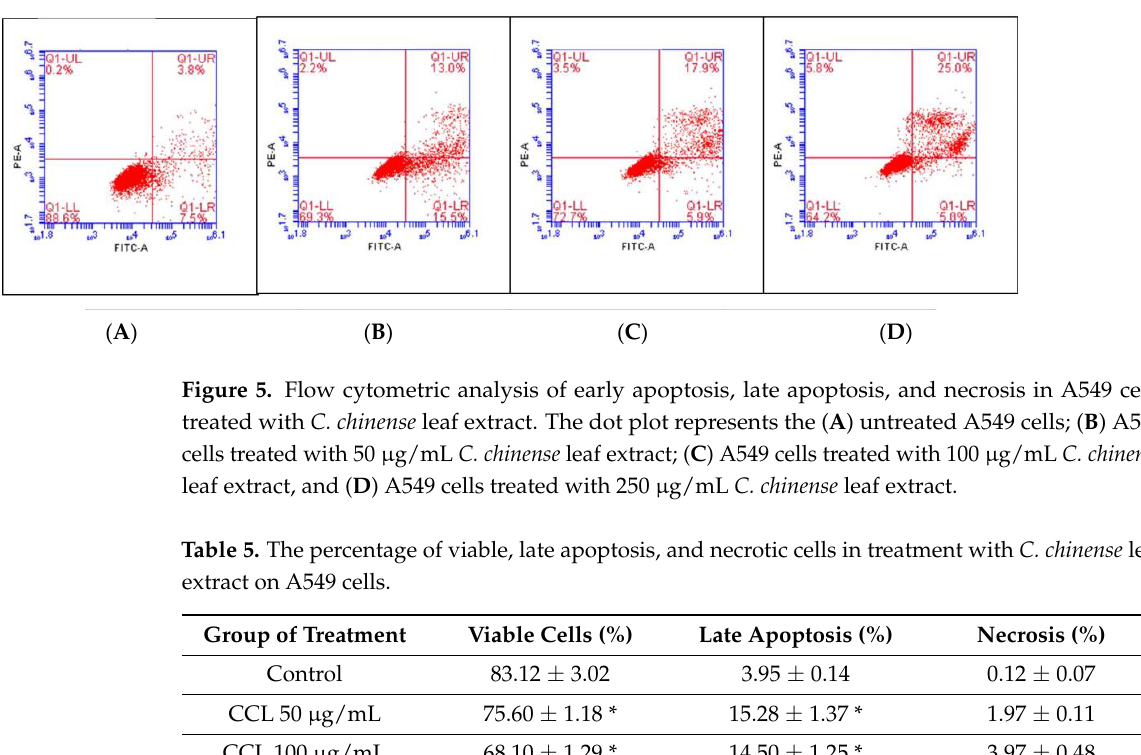
Figure 4. Effect of C. chinense l eaf extract on HaCaT cell viability after incubation for 24, 48 and 72 h. Data are shown as the mean ± SD ( n = 3).